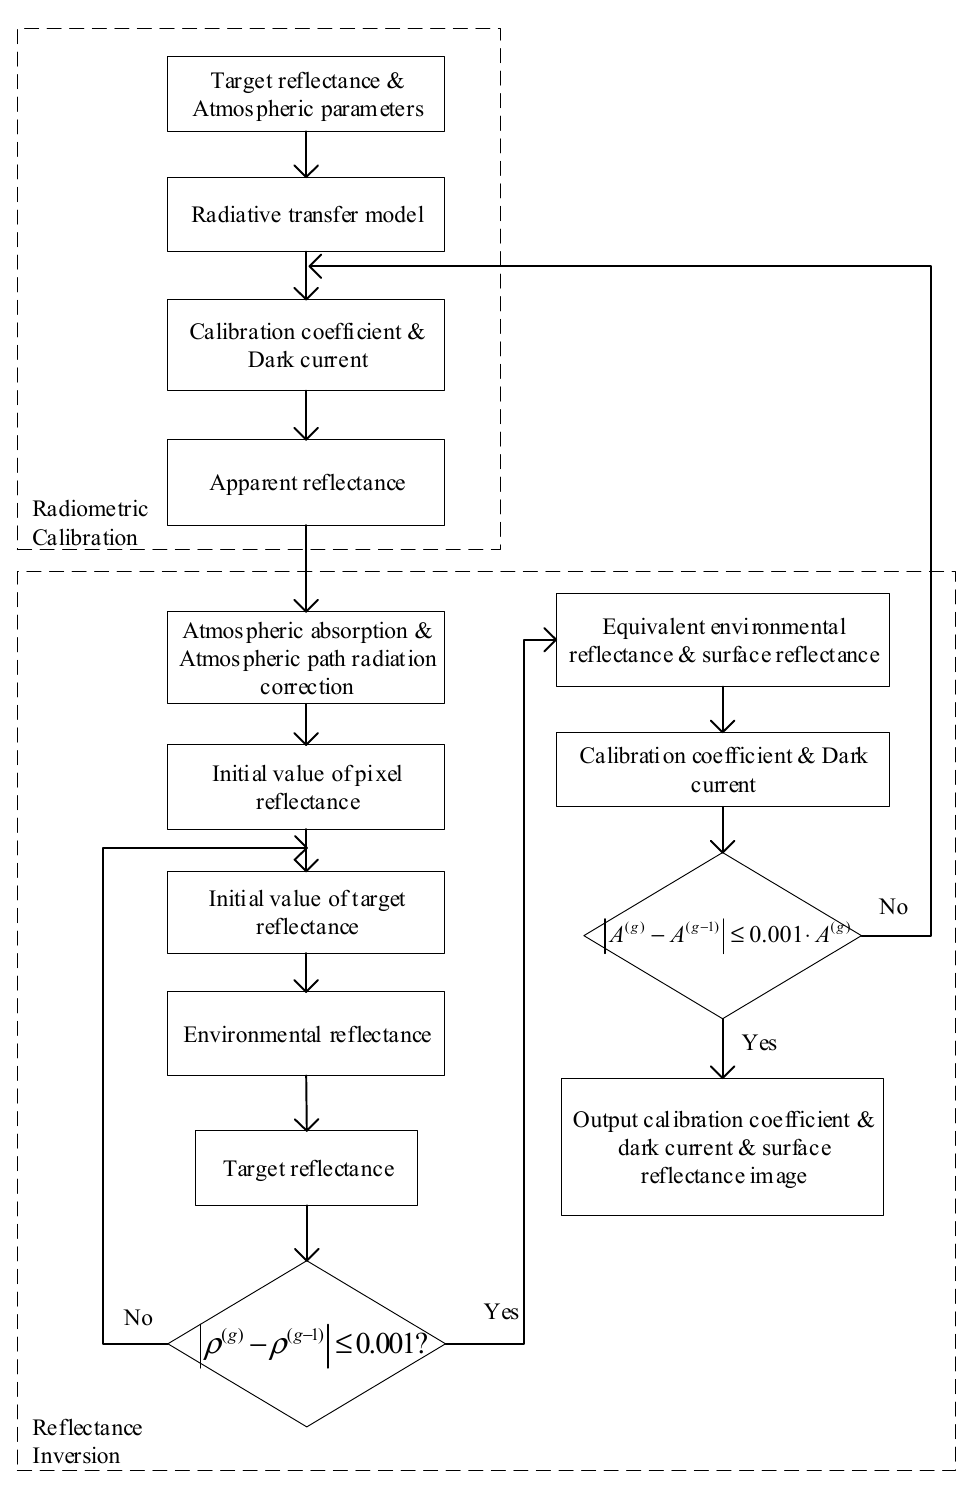
Figure 2. RCRII model flow